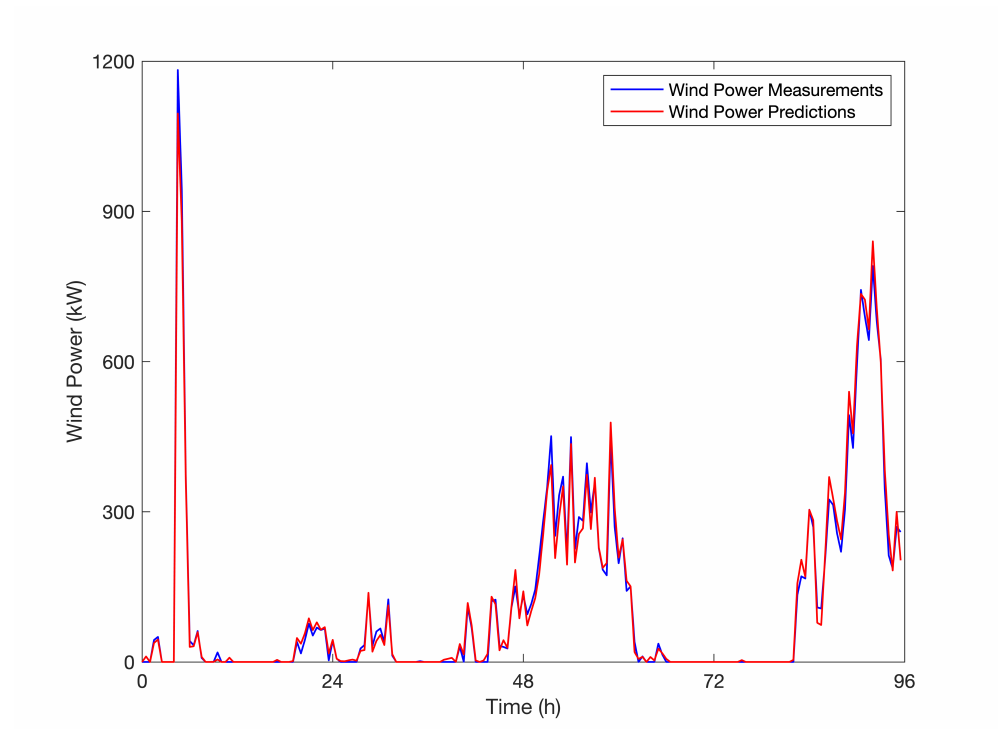
Figure 5. Evaluation of the power curve model using the 4-day test dataset of the wind speed and wind power